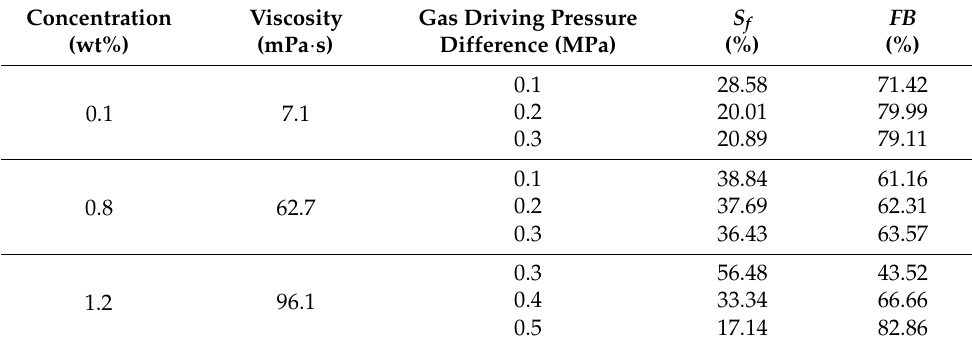
Table 4. Summary of experimental